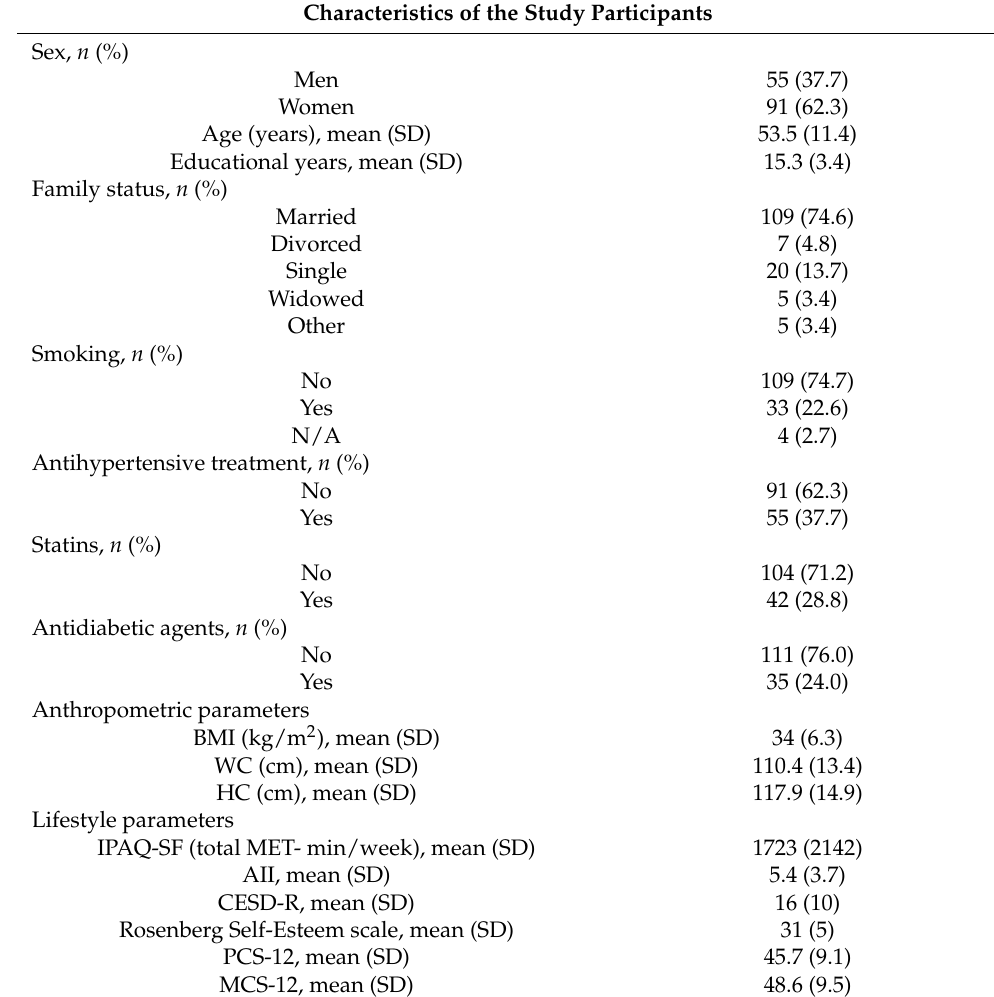
Table 1. Descriptive characteristics of the study